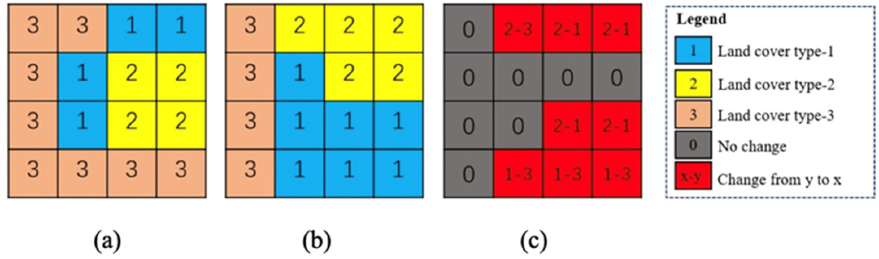
Figure 3. Various types of LCC. ( a ) Land cover map at T1; ( b ) Land cover map of T2; ( c ) Land cover change results between T2 and T1.